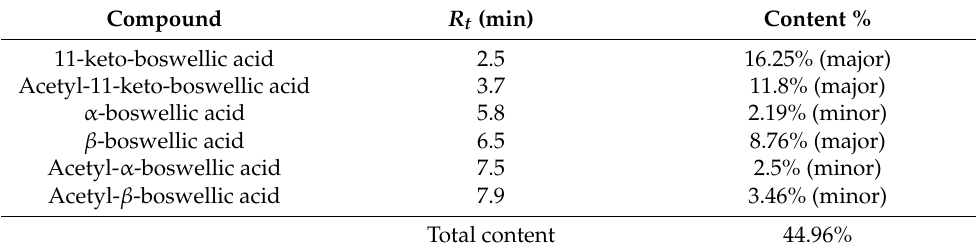
Table 1. HPLC determination of BAs in frankincense